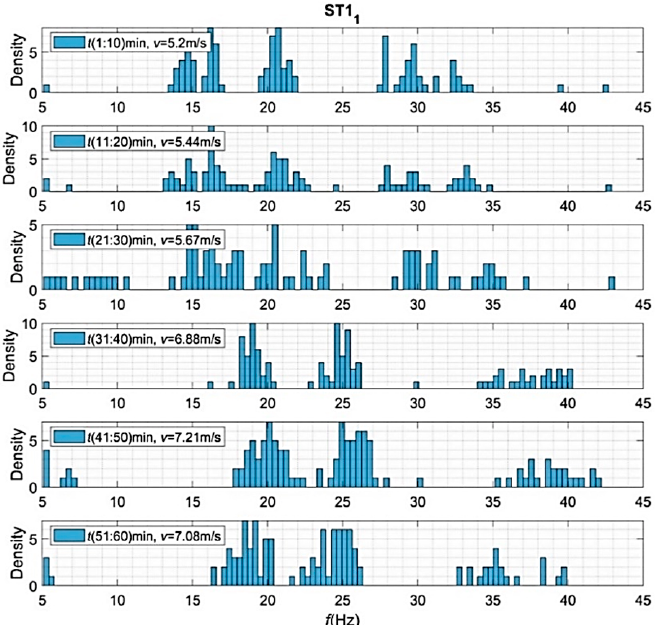
Figure 17. The density of 12 most significant frequency peaks calculated within 10 min intervals by ST1 with corresponding mean wind velocities given in the legend.